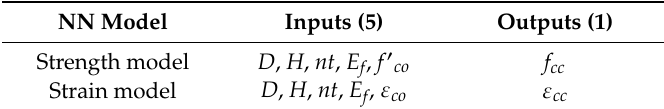
Table 4. The five inputs and the single output of the neural network (NN) strength and strain models